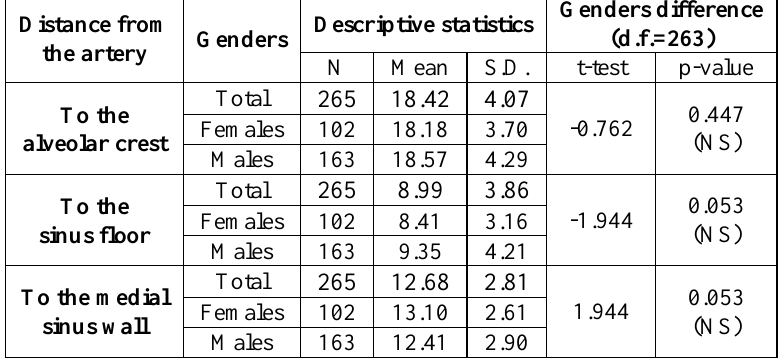
Table 1: Descriptive statistics and genders difference of PSAA measurement parameters Distance